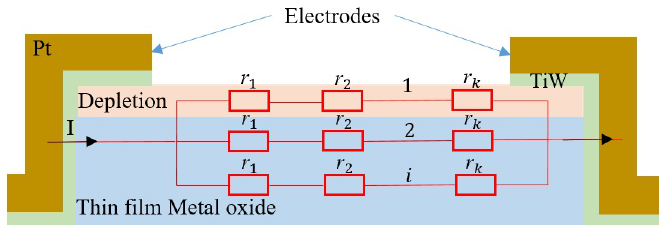
Figure 8. Device configurations and the corresponding equivalent circuit to investigate the adsorption of the metal oxide film in SMO gas sensors.